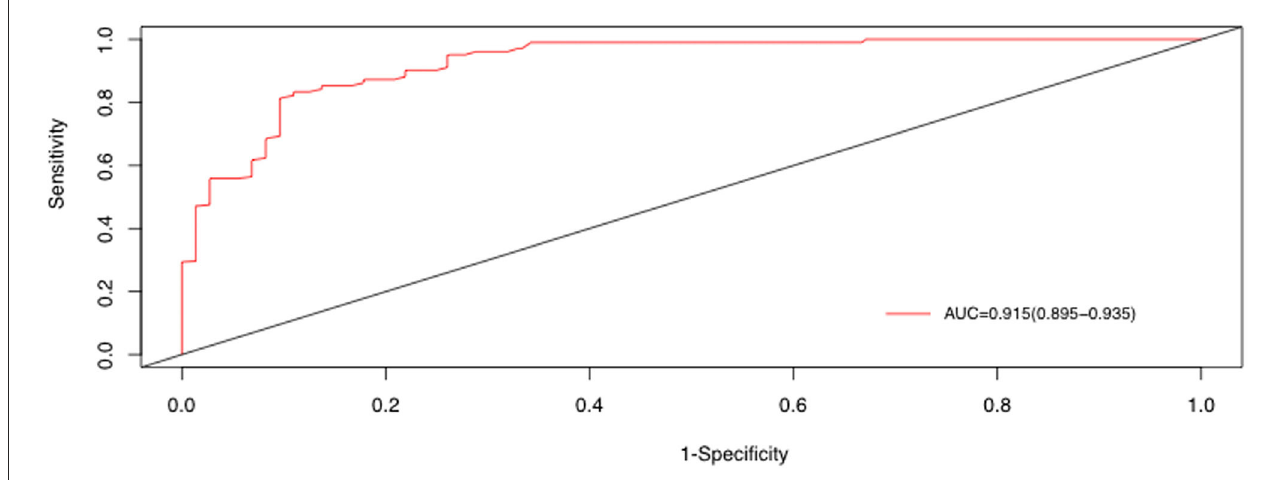
FIGURE5 ROC curve for distinguishing BMPs, derived from the combination of 25(OH)D, IL-8, polylobular infection, and MP DNA copies.